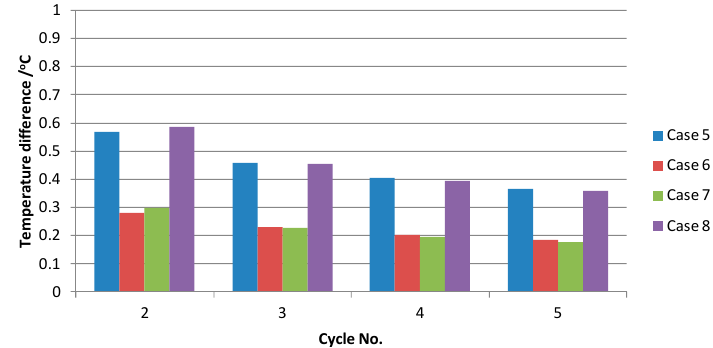
Figure 10. ∆ T of each cycle for Cases 5–8 under di ff erent ratios of P heat to P feeding. Figure 10. Δ T of each cycle for Cases 5–8 under different ratios of P heat to P feeding. When P heat deviates 5% from P feeding , it means that voltage fluctuates 24 mv in 500 kA pots.